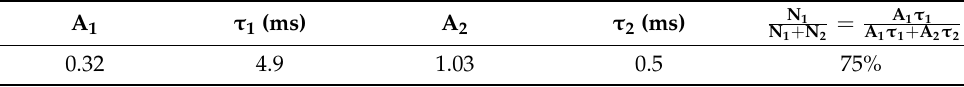
Table 2. Table of the obtained values of A 1 , τ 1 , A 2 , τ 2 , N 1 , and N 2